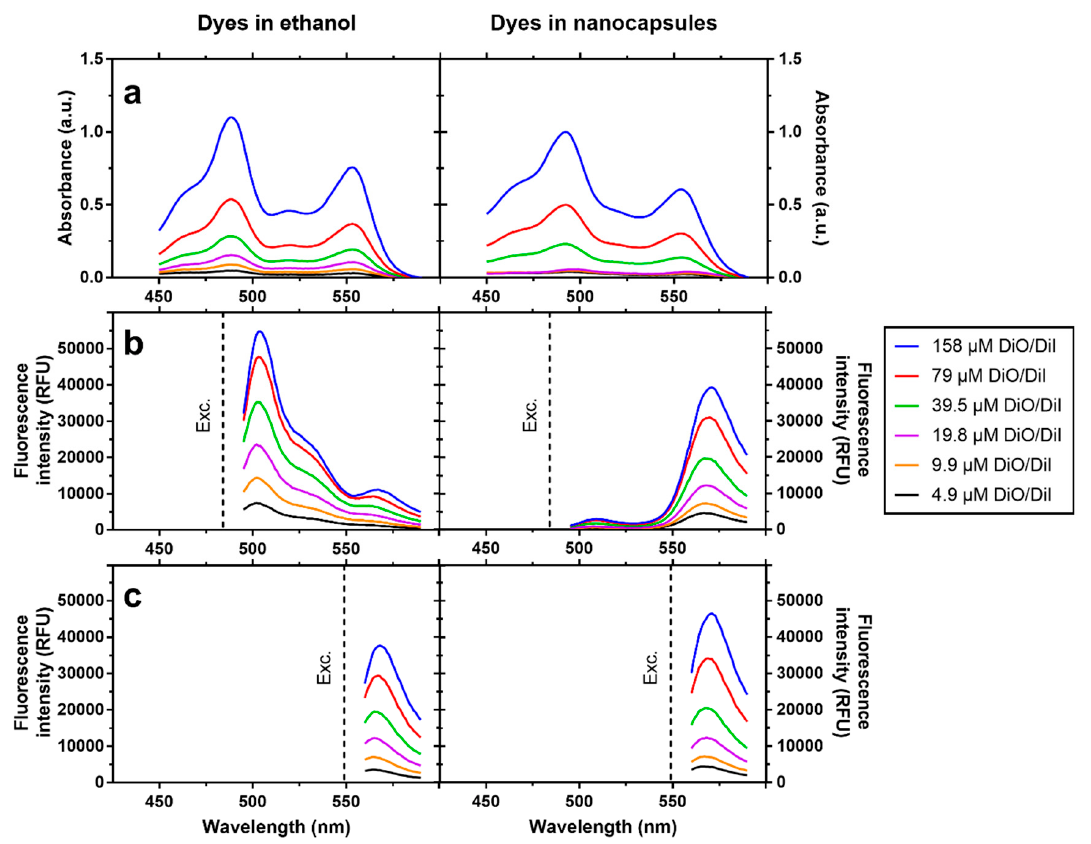
Figure 2. Spectroscopic properties of equimolar mixtures of DiO/DiI diluted in ethanol and equivalent concentrations of DiO/DiI in nanocapsules diluted in PBS (as shown in label). ( a ) Absorbance spectra. ( b ) Fluorescence emission spectra of DiO (donor), upon excitation (indicated by dotted line, λ ex = 484 nm). ( c ) Fluorescence emission spectra of DiI upon excitation (indicated by dotted line, λ ex = 549 nm).